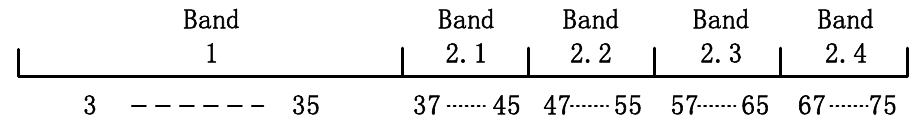
Figure 10. Schematic diagram of harmonic elimination.